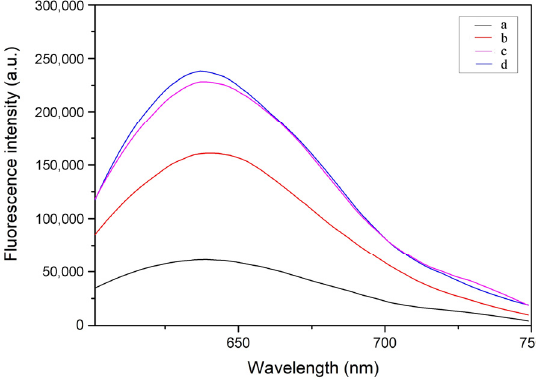
Figure 3. Fluorescence response of the reaction solution with different conditions: ( a ) SMBs-cDNA1+Apt+AuNPs-cDNA2+DNA-AgNCs; ( b ) SMBs-cDNA1+Apt+AuNPs-cDNA2+ S. Typhi-